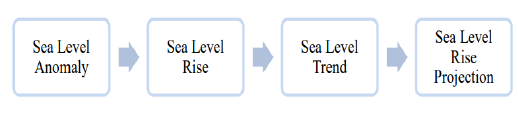
Figure 2. The sequence of determination sea level rise